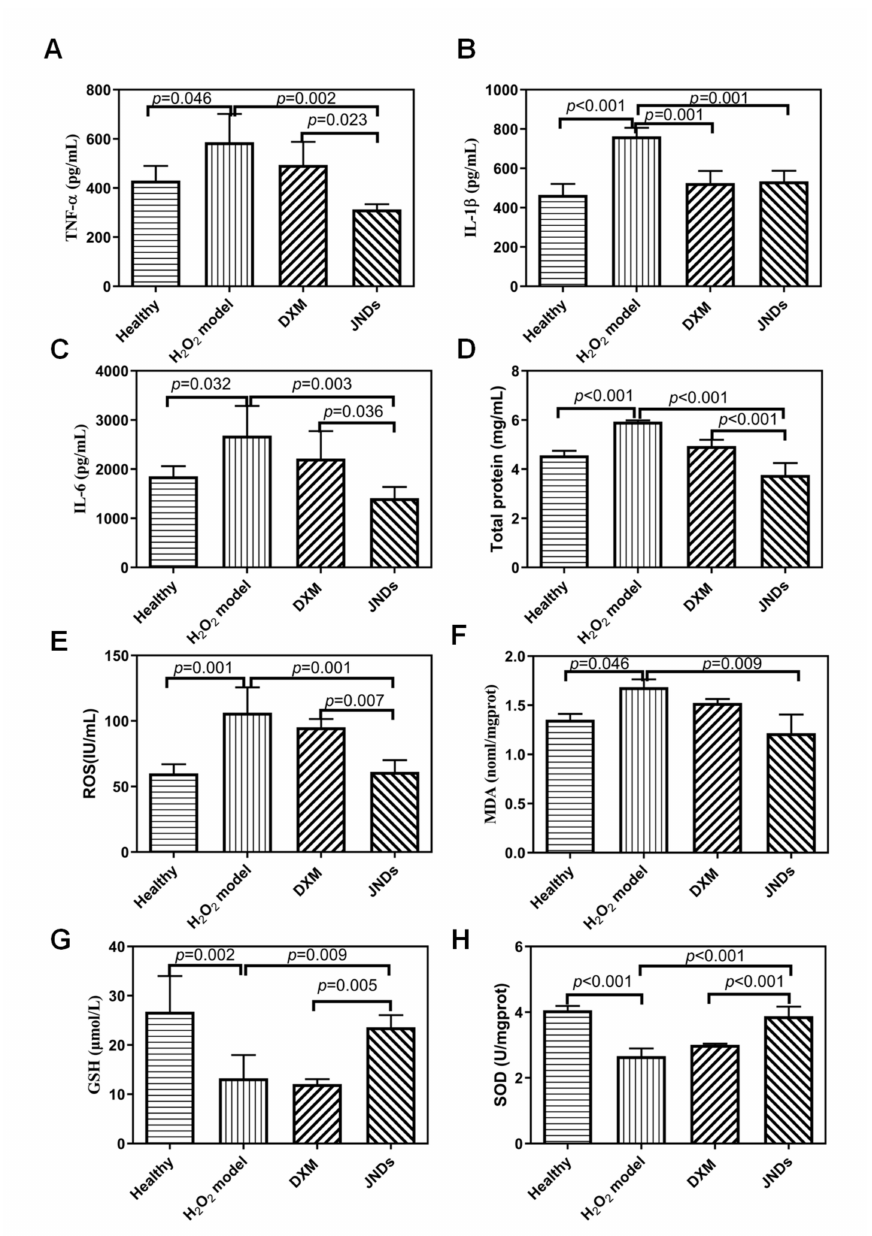
Figure 5. Expressions of TNF- α ( A ), IL-1 β ( B ), IL-6 ( C ), total proteins ( D ), reactive oxygen species (ROS) ( E ), malondialdehyde (MDA) ( F ), glutathione (GSH) ( G ) and superoxide dismutase (SOD) ( H ). The data are presented as means ± SD ( n =